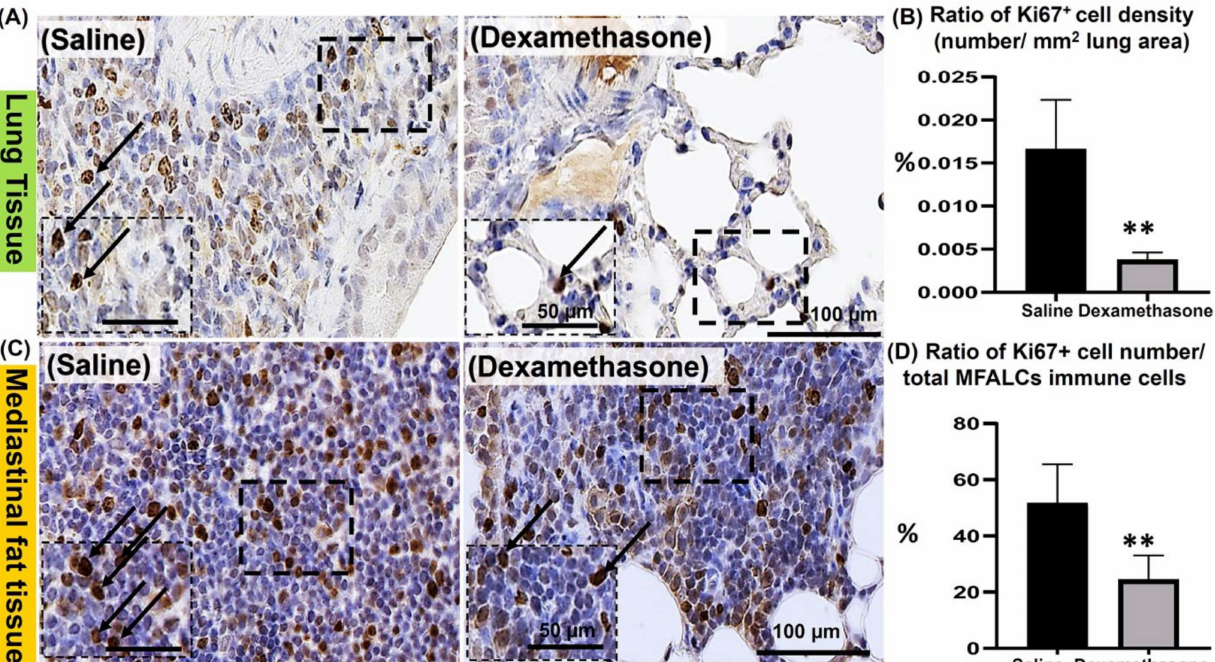
Figure 2. Analysis of the degree of proliferation of immune cells in the lungs and mediastinal fat associated-lymphoid clusters (MFALCs) in female Lpr mice. ( A , C ) Representative images of the immunohistochemical-stained lung ( A ) and mediastinal fat tissue sections ( C ) stained with anti-Ki67 antibody in both the saline and dexamethasone groups. ( B , D ) Representative graphs showing the percentage for the ratio of Ki67 + proliferating cell density in the lungs ( B ) and Ki67 + proliferating cell number/total immune cell number in the MFALCs ( D ). A highly significant value (**) was observed between the saline and dexamethasone groups ( p values < 0.01), where n = 5 in each experimental group. Analysis was conducted using the Mann–Whitney U test. Data are presented as mean values ±